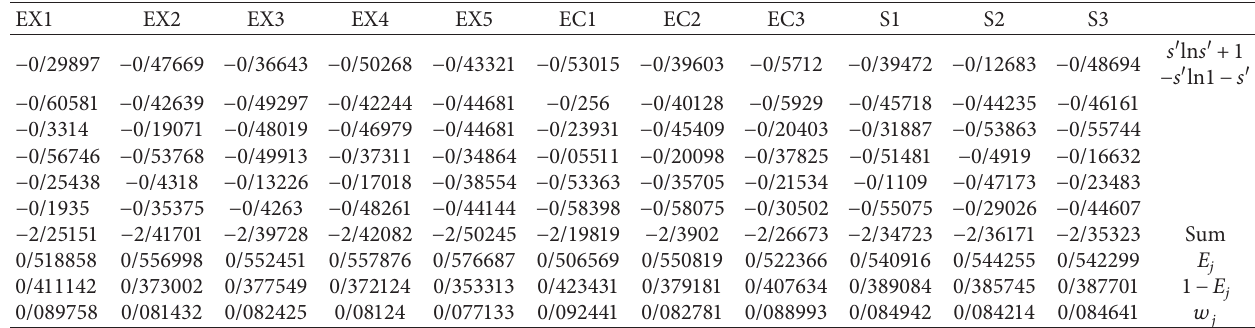
Table 7: Weight of